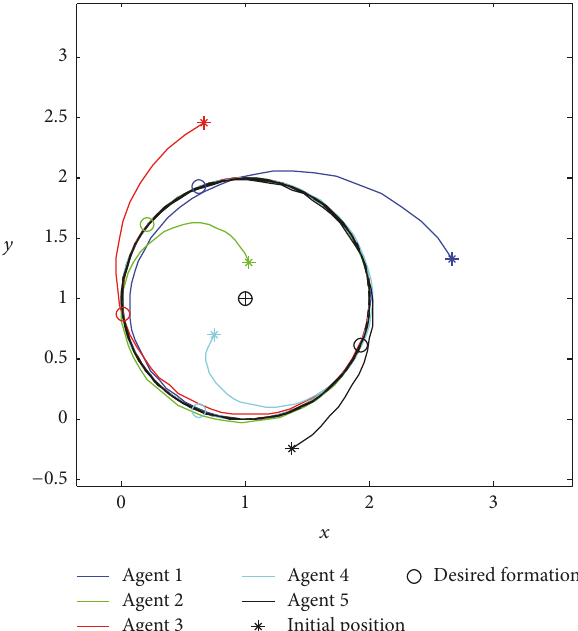
Figure 3: Circular formation trajectories 𝑝 𝑘 (𝑡) with a fixed